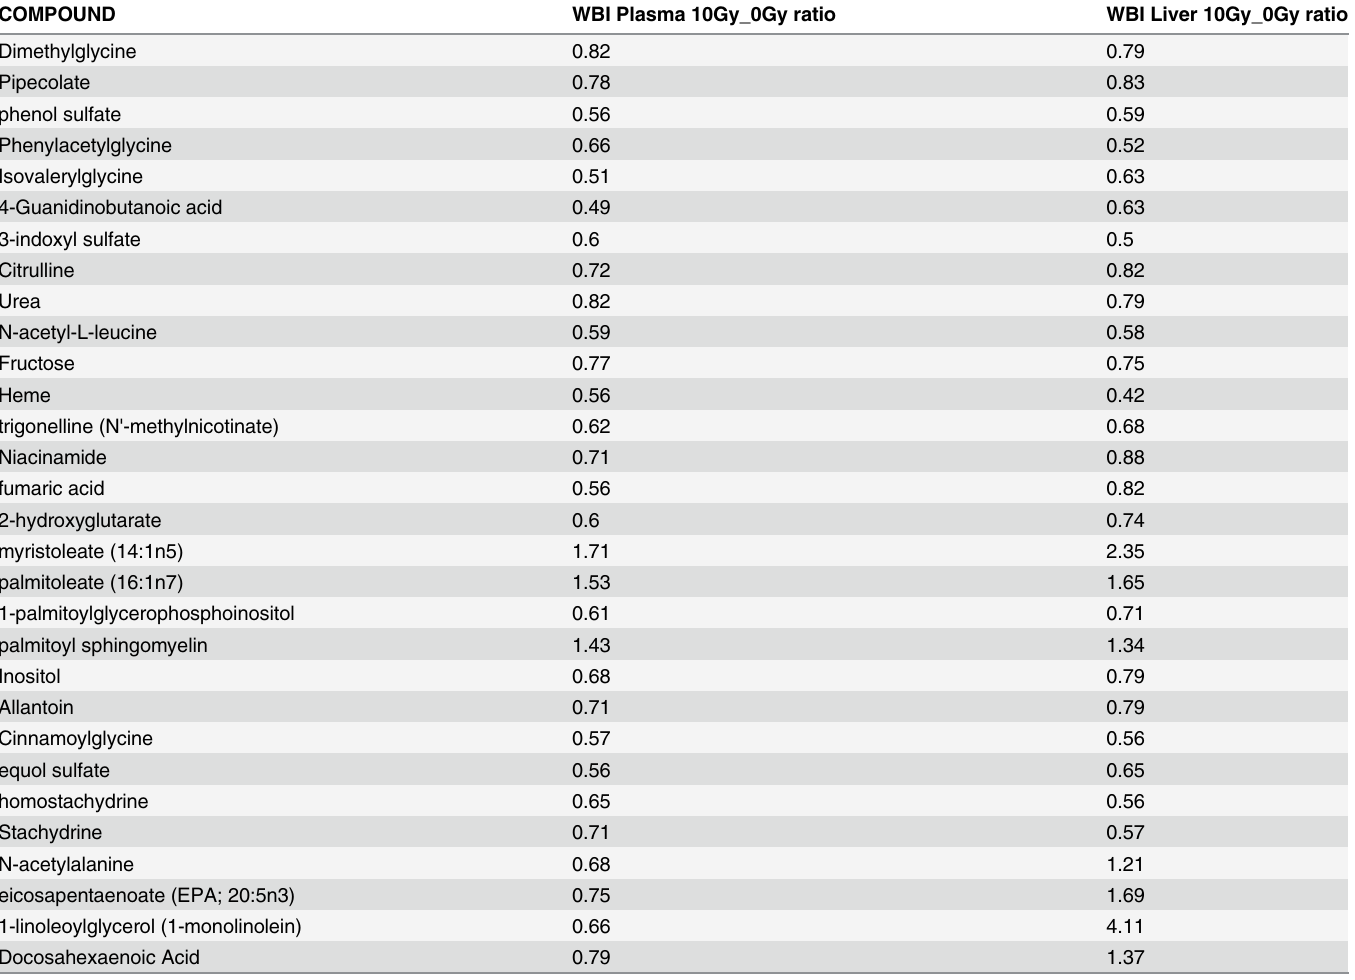
Table 2. Levels of metabolites changing between 0 Gy and 10 Gy in liver and